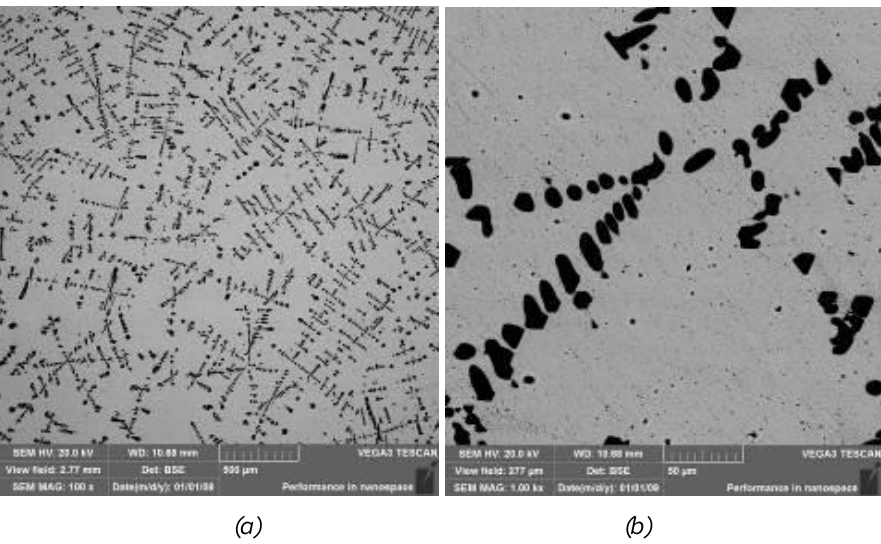
Fig. 2. SEM image of the Bi 85.9 Cu 14.1 alloy: (a) magnification 100X; (b) magnification